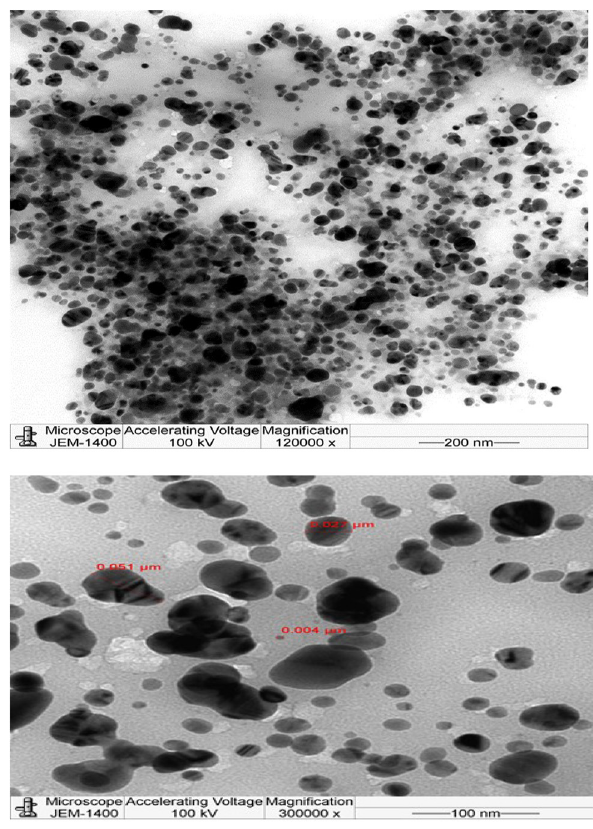
Figure 3: Transmission electron microphotograph showing the morphology and size of synthesized Si - AgNPs.